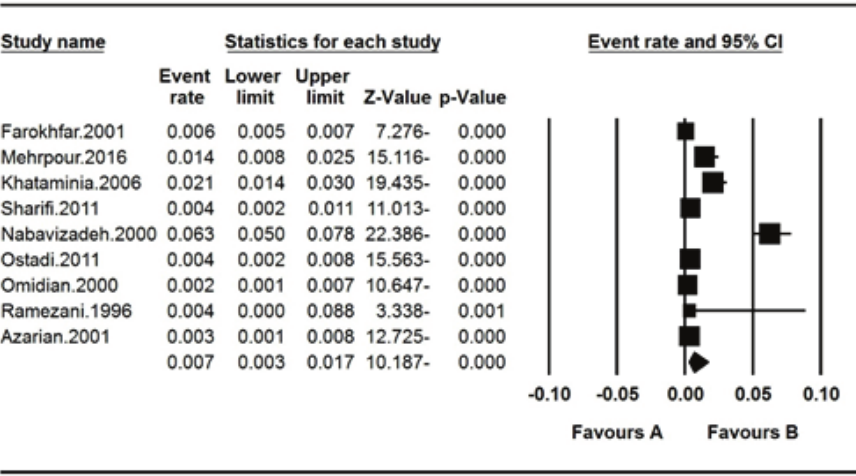
Figure 4. The prevalence of color blindness in Iranian female